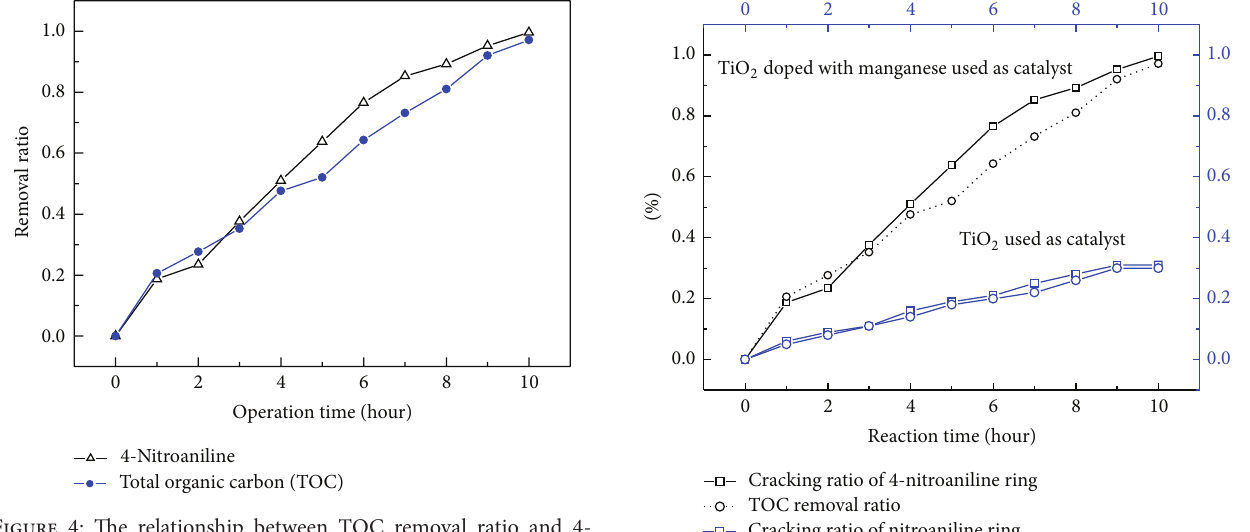
Figure 4: The relationship between TOC removal ratio and 4- nitroaniline removal ratio during the reaction (c (4-nitroaniline) = 100mg/L; voltage = 12 V; ultraviolet ray dosage = 1200 𝜇 W/cm 2 ).